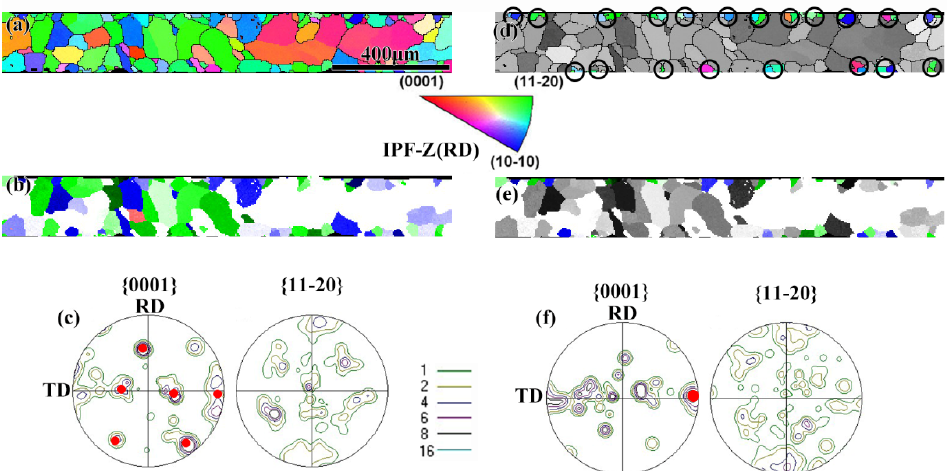
Figure 10. Orientation maps with IPF colors and texture components and pole figures of 90% cold-rolled sample following annealing at 1100 ◦ C under Ar atmosphere, cooled with cooling rate of 400 ◦ C/h to 860 ◦ C and quenched with water, ( a – c ) entire sample; ( d – f ) surface grains.